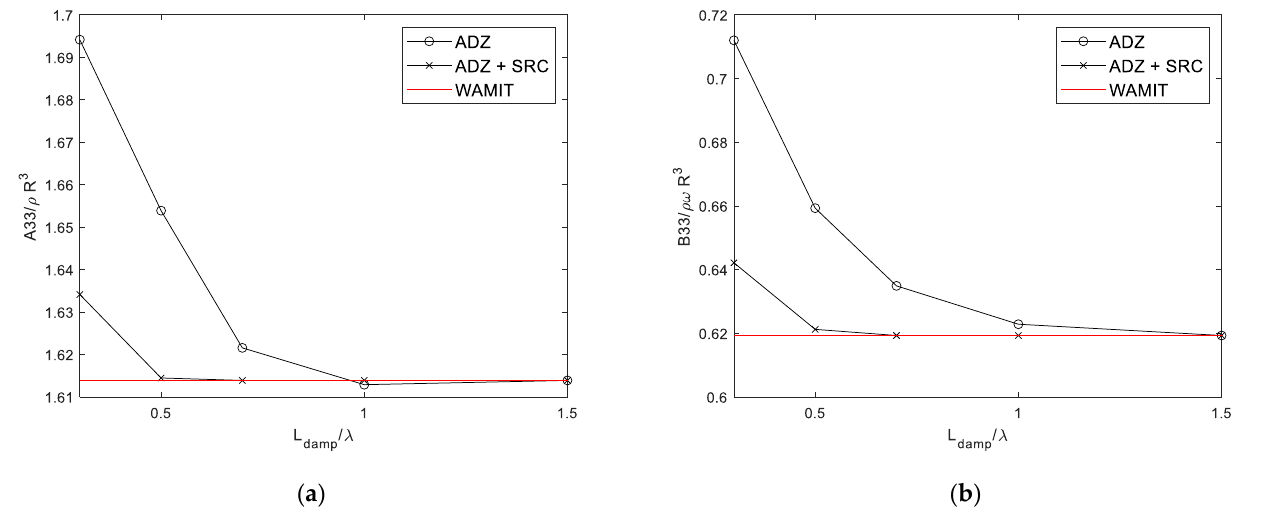
Figure 12. Numerical results of the combined radiation condition: ( a ) nondimensional heave-added mass varying the length of the damping zone ( 𝜔 = 1.5 rad/s ); ( b ) nondimensional heave radiation damping coefficient varying the length of the damping zone ( 𝜔 = 1.5 rad/s ).